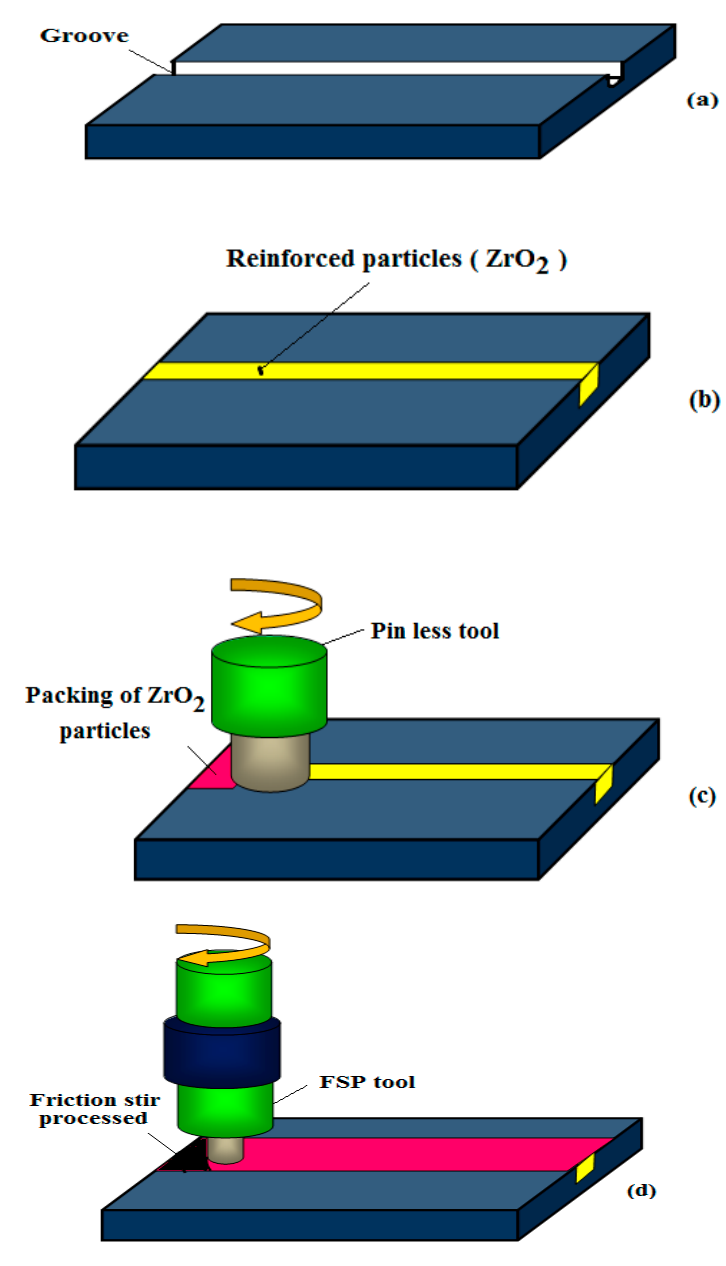
Figure 2. FSP process procedure: ( a ) square groove on the base material; ( b ) reinforced particles filling in the groove; ( c ) compaction process using a pinless tool; and ( d ) FSP process.